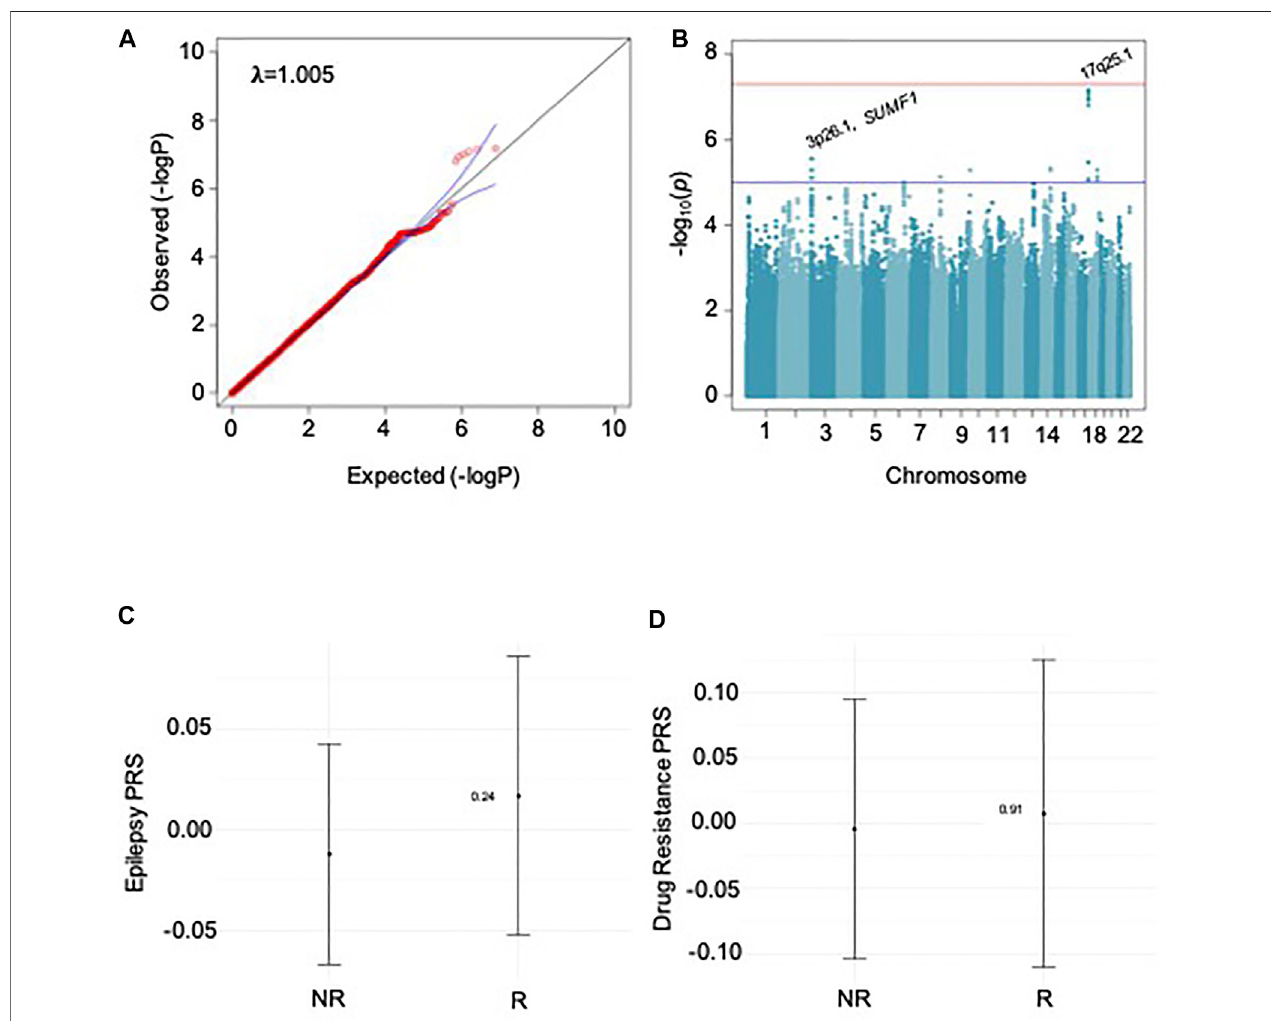
FIGURE 1 | Results for sodium channel-active ASMs. A and B show results for GWAS, C and D for PRS analysis. A: QQ plot shows no relevant p-value in fl ation; lambda-value (cid:2) 1.005. B: Manhattan plot of GWAS; locations of SNPs with p-value ≤ 5 × 10 – 6 are marked. C: Results for PRS-analysis PRS for epilepsy risk based on the ILAE 2018 metadata. D: Results for PRS-analysis for PRS for risk of ASM-speci fi c drug response.